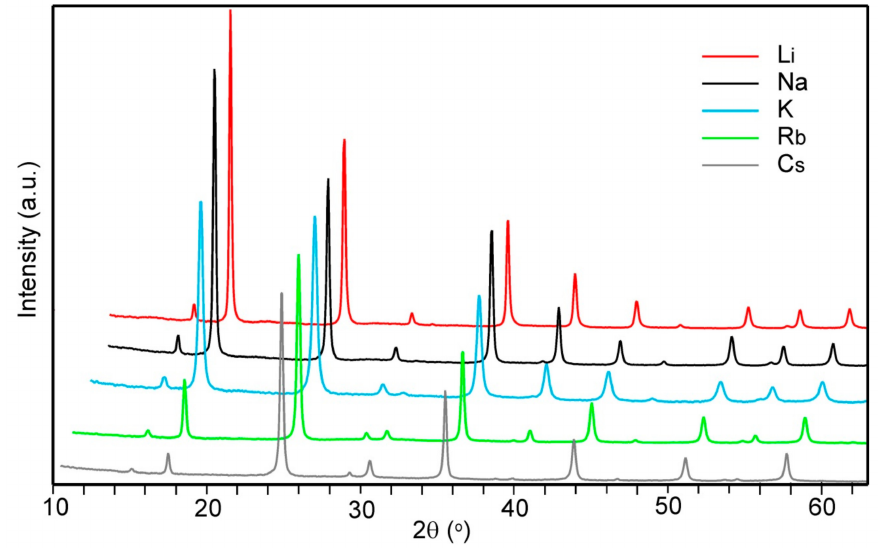
Figure 4. PXRD patterns for A 2 / 3 Cu[Fe(CN) 6 ] 2 / 3 compounds with A = Li, Na, K, Rb and Cs. The relative intensities have been normalized to the intensity of the 220 reflection at 2 θ –25 ◦